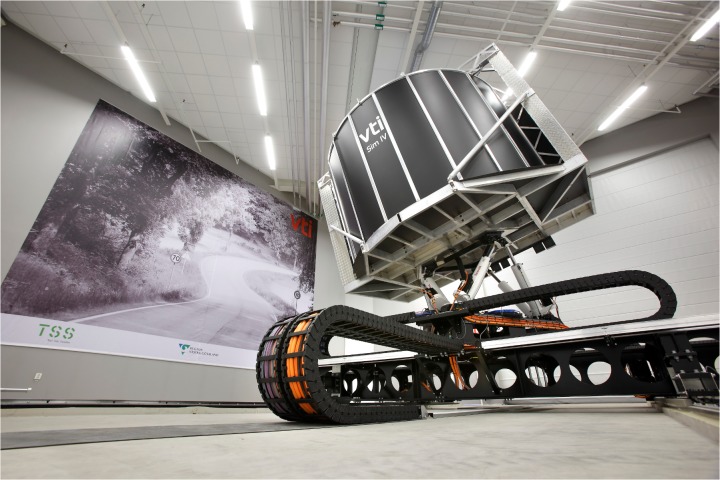
VTI’s simulator IV.